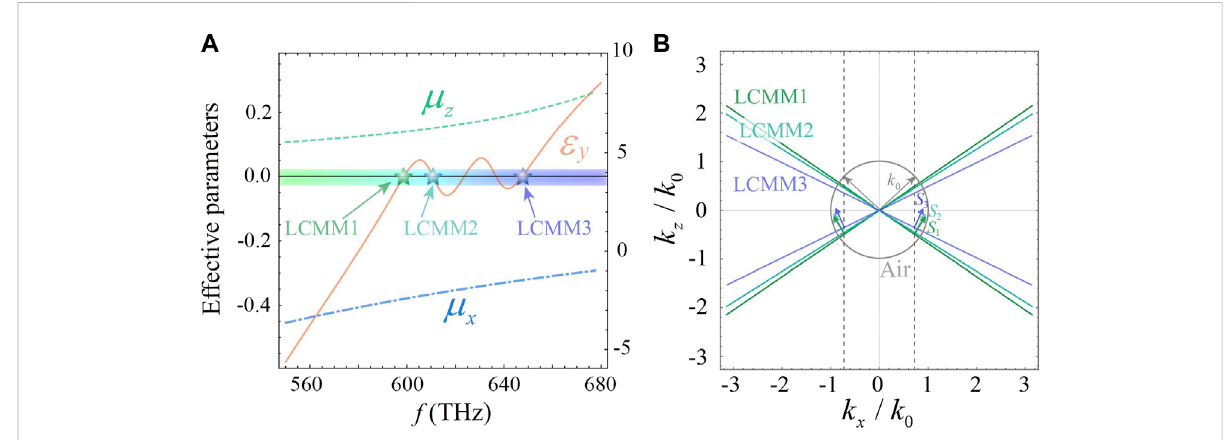
FIGURE 6 MLCMM based on the step-like multilayer structure. (A) Effective real part of anisotropic electromagnetic parameters based on the step-like multilayer structure. μ x , ε y , and μ z are represented by blue dash dotted line, red solid line, and green dashed line, respectively. (B) Directional refraction of three LCMMs expressed from the linear dispersion.